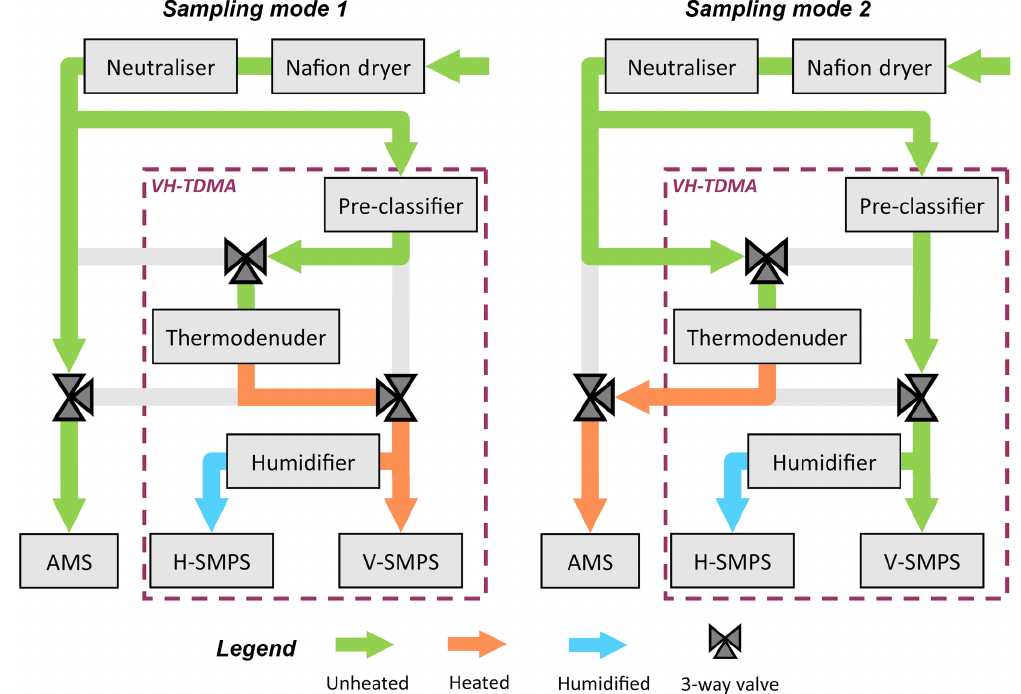
Figure 1. Schematics of the VH-TDMA–AMS sampling system, demonstrating the alternating flow paths used for consecutive samples.